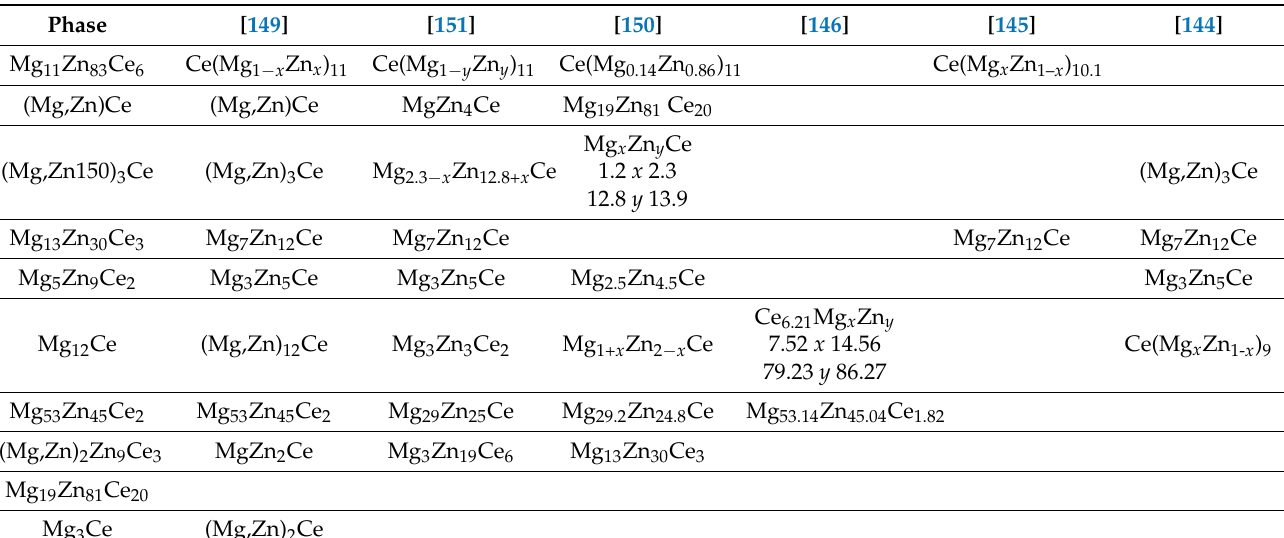
Table 1. Reported ternary phases in the Mg-Zn-Ce system in comparison with literature.